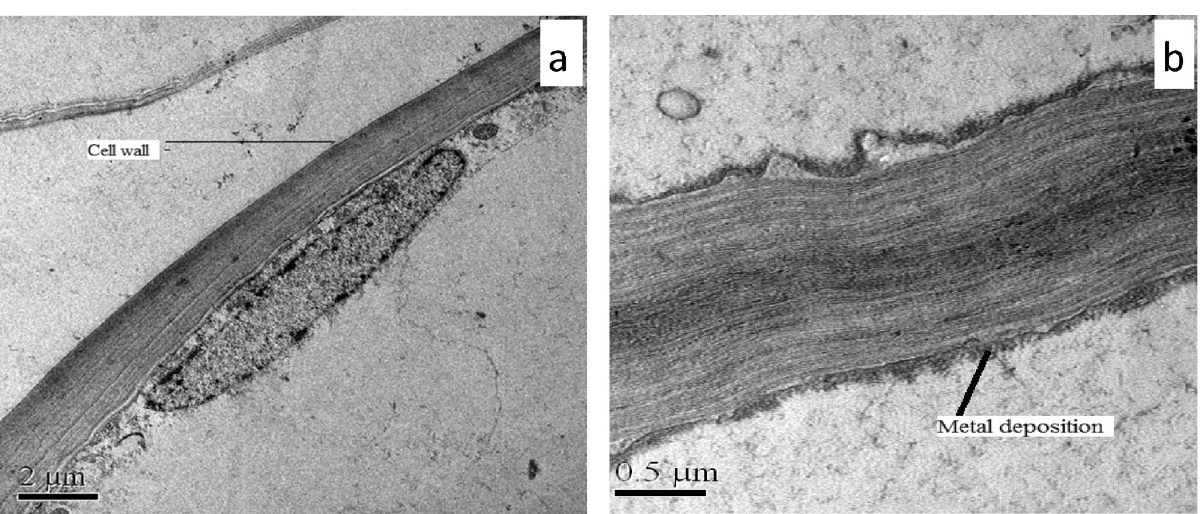
Figure 8. TEM micrographs of root cells of T. natans : ( a ) cell wall of control plant, ( b ) Sb treated cell wall showing numerous black